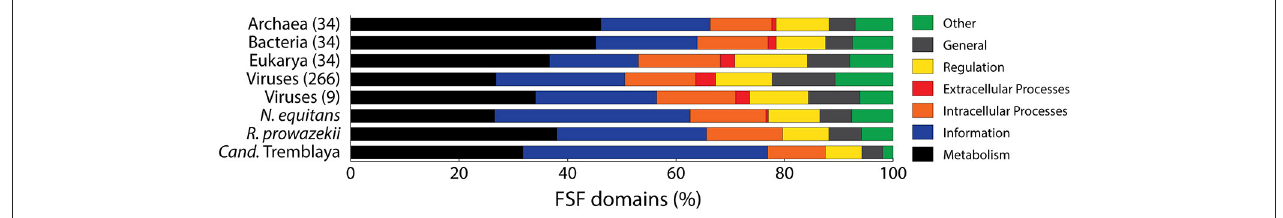
FIGURE 6 | Cellular endosymbionts differ from free-living organisms and viruses in their FSF composition profiles. Annotation of FSF domains into one of the seven major functional categories ( Metabolism, Information, Intracellular Processes, Extracellular Processes, Regulation, General, and Other ) for archaeal, bacterial, eukaryal, and viral proteomes sampled in our study (Nasir and Caetano-Anollés, 2015) and for nine viral and three extremely reduced cellular proteomes included by Harish et al. (2016) in their reconstructions Cand . Nausia deltocephalinicola was not part of our reconstructions (encodes only 55 universal FSFs). Obligate endosymbionts or parasites often increase the repertoire of informational FSF domains, as showcased by Cand . Tremblaya included by Harish et al. (2016), and for 311 other known obligate and facultative parasitic organisms in (Figure 3 in Nasir et al., 2011). Functional scheme as defined by Christine Vogel in SUPERFAMILY database (http://